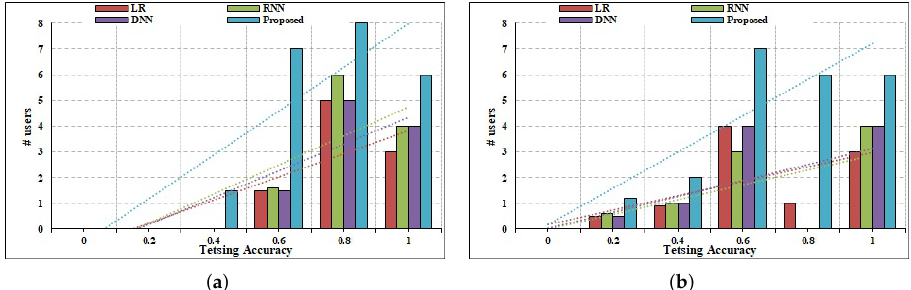
Figure 9. User Testing Analysis. ( a ) GRU-Model 1, ( b ) GRU-Model 2.